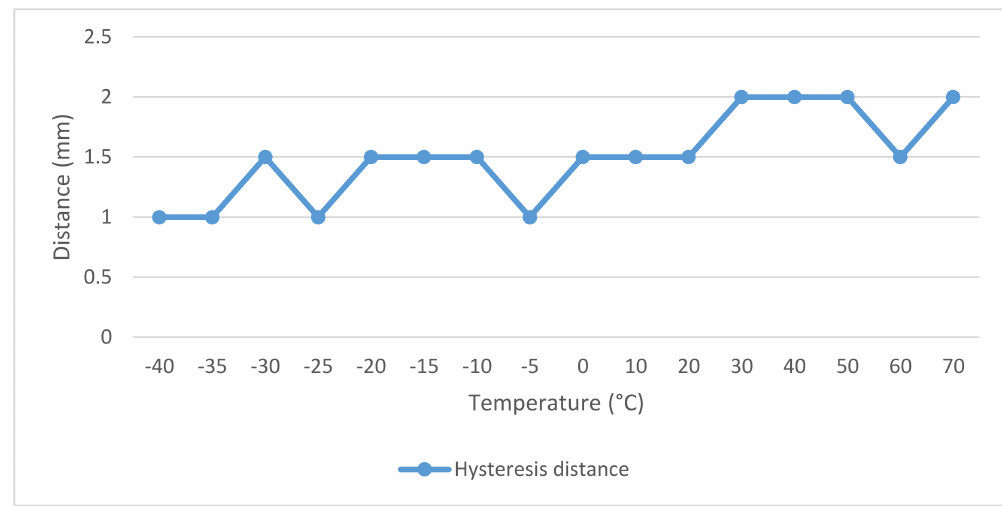
Figure 9. Graphical representation of the values of the hysteresis phenomenon of the magnetic contact USP